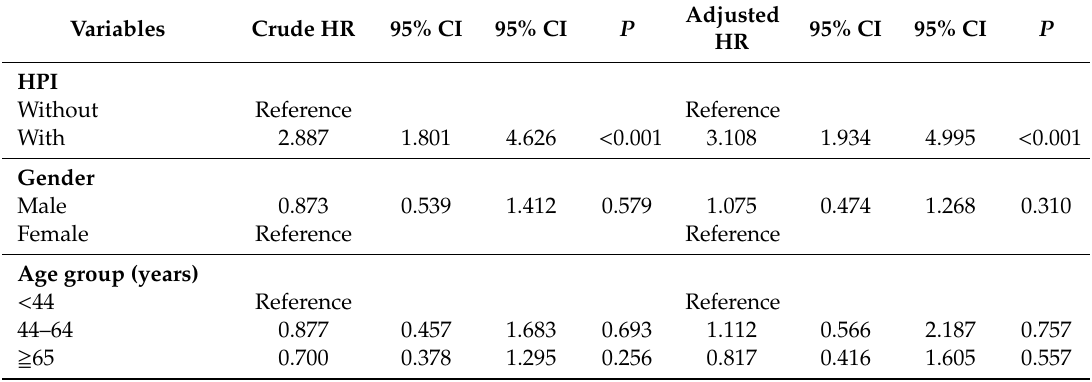
Table 2. Factors of irritable bowel syndrome (IBS) by using Cox